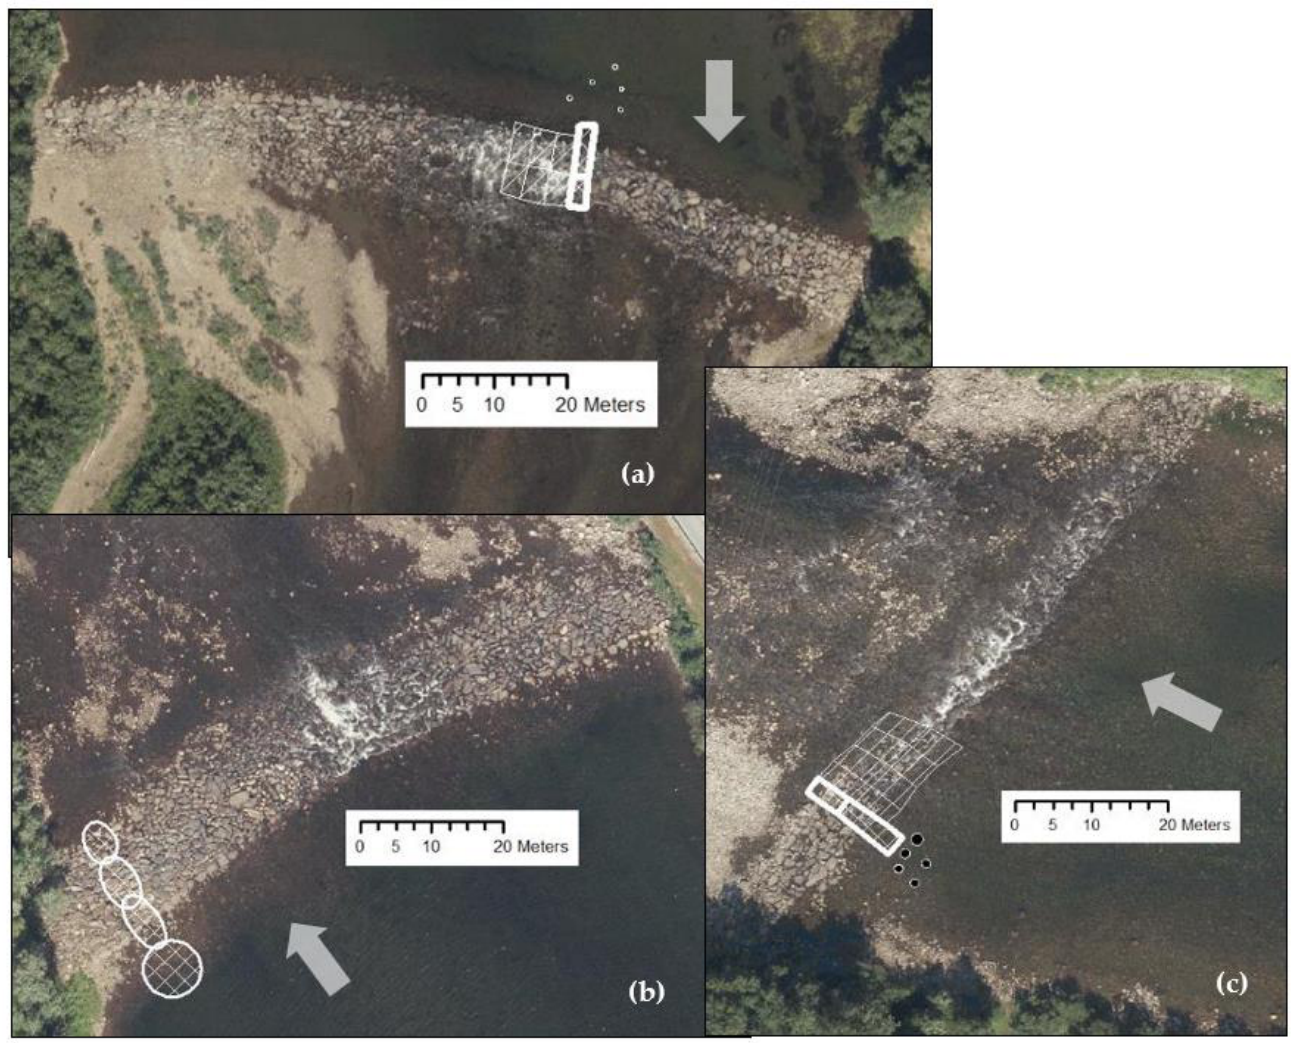
Figure 4. Polygons for weir adjustment in weirs no. 1 ( a ), 22 ( b ), and 7 ( c ). For ( a , c ), the cross-hatched, thickly outlined polygons represent a 2 m deep and wide channel across the weir, while the thin-lined polygons represent a minor lowering of the weir level, gradually increasing towards the deep channel. White-outlined black dots indicate the placement of rocks for hydraulic disruption at the entry point to the deep channel. For weir 22 in picture ( b ) the cross-hatched, thickly outlined polygons represent gradually lowered cell pools. The thick white arrow indicates flow direction.